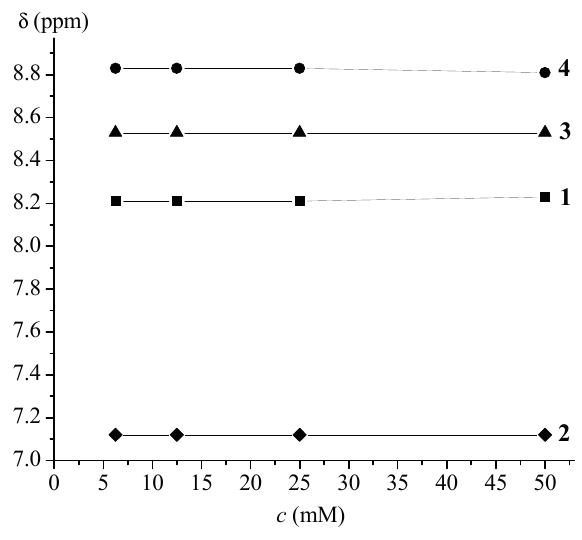
Figure 2. Concentration dependent NH chemical shifts of peptides 1 – 4 . [ 1 H-NMR trans measurements were performed for a series of 6.25, 12.5, 25 and 50 mM solutions].